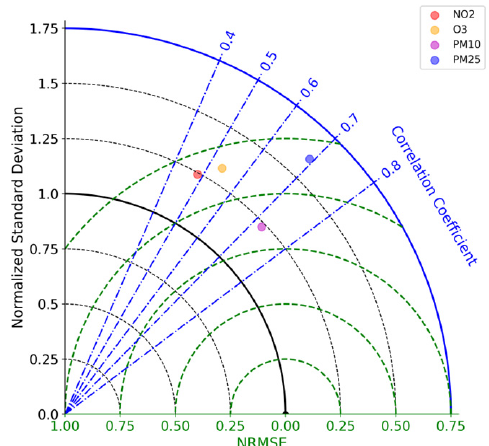
Figure 4. Taylor diagram on the left showing the statistical comparison between observed and model simulated values for Nanjing from 1 January to 28 February 2019.